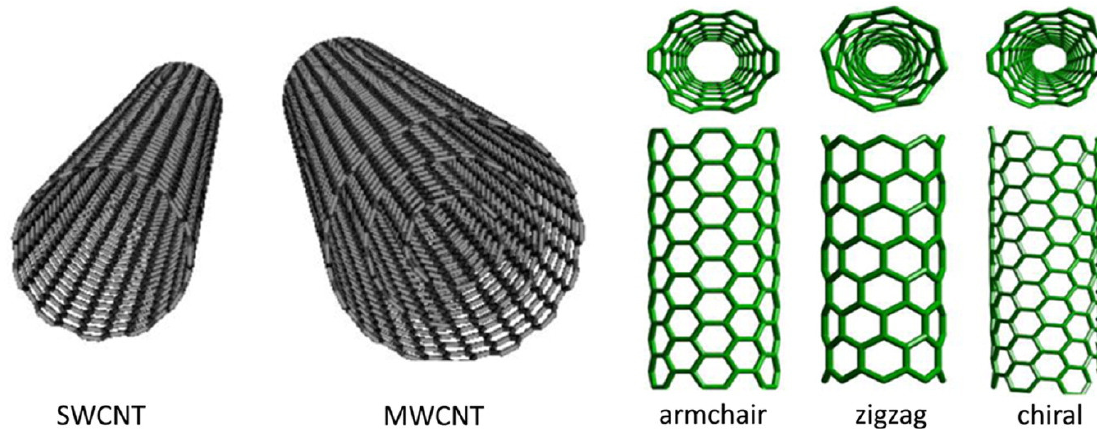
Figure 13. The graphical representation of CNTs [ 111], open access.